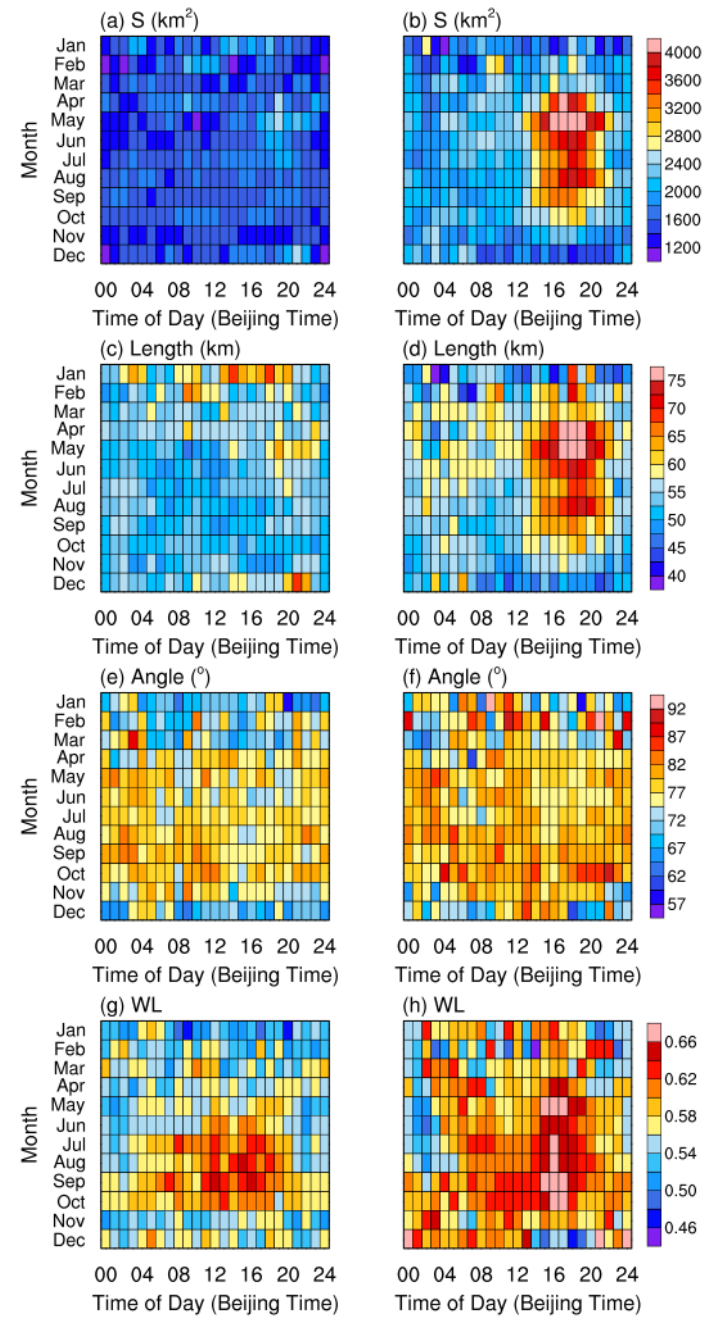
Figure 7. Intra-annual variations in the parameters of oceanic and continental rain clusters: ( a,b ) S , ( c,d ) length, ( e,f ) rotation angle and ( g,h ) WL . The left-hand columns show the parameters of oceanic rain clusters and the right-hand columns show the parameters of continental rain clusters (Beijing Time, UTC+8).